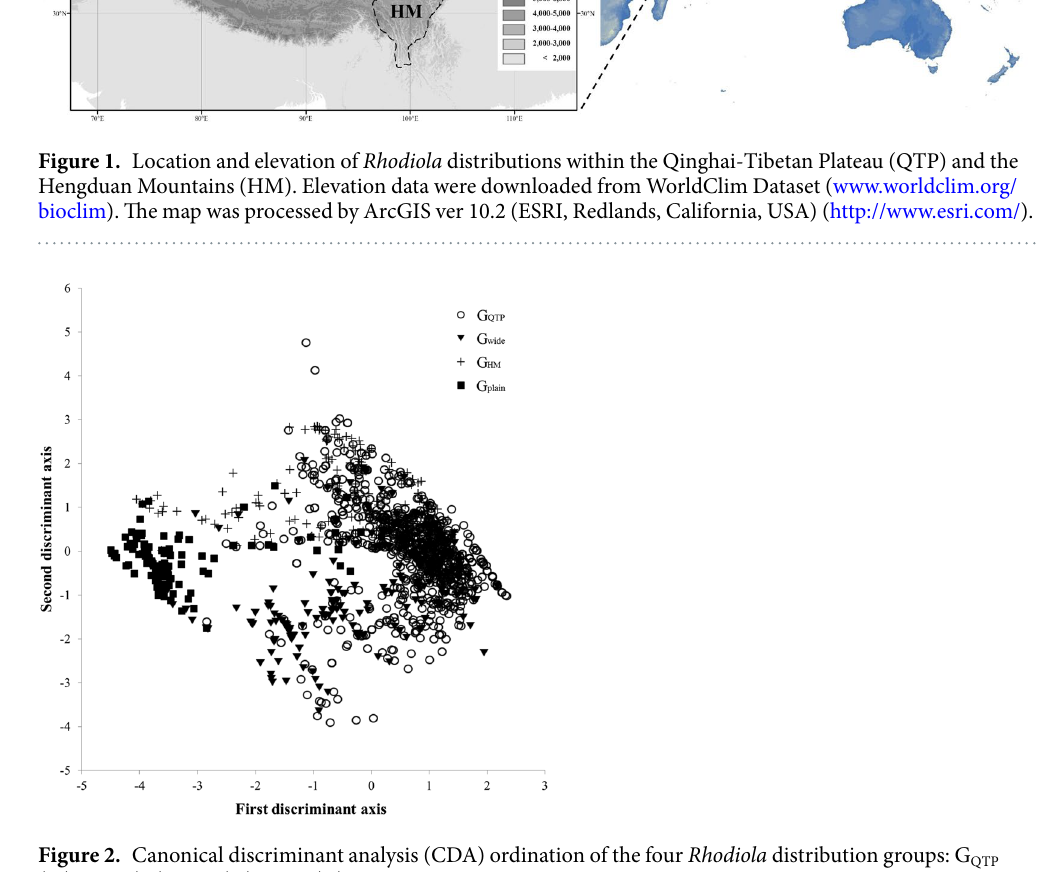
Figure 2. Canonical discriminant analysis (CDA) ordination of the four Rhodiola distribution groups: G QTP ( ○ ); G wide ( ▽ ); G HM ( + ); G plain ( □